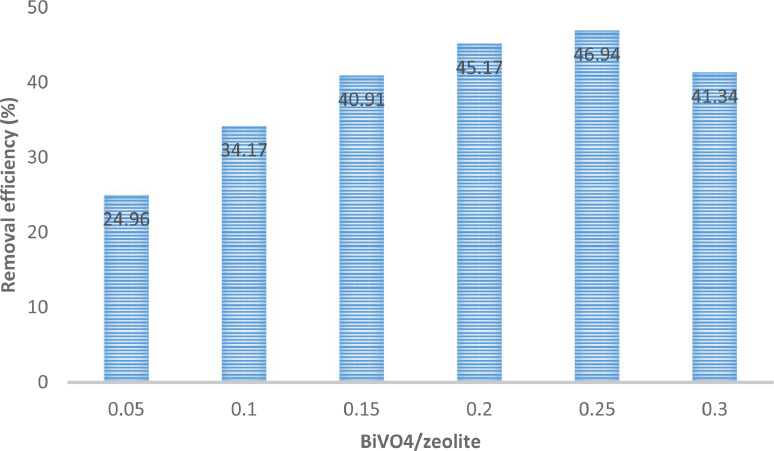
Effect of BiVO4/zeolite dosage on AO10 dye removal (dye concentration = 20 mg/L, pH = 3, Contact time =  200 min).